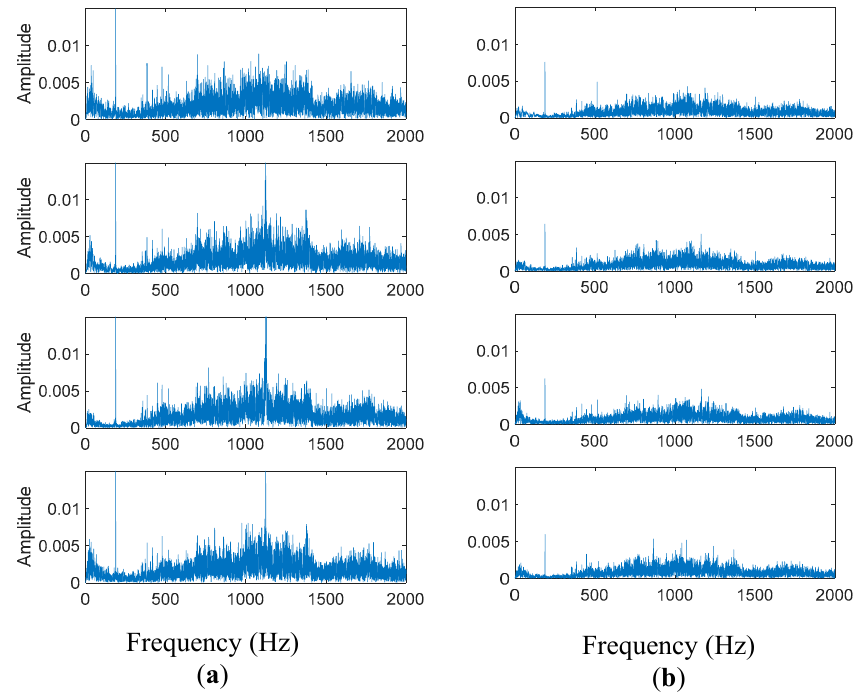
Figure 10. The frequency spectrum of the audio signal of a segment in time domain corresponding to the gear set in ( a ) good condition and ( b ) with fault. Sensors 2019 , 19 , x